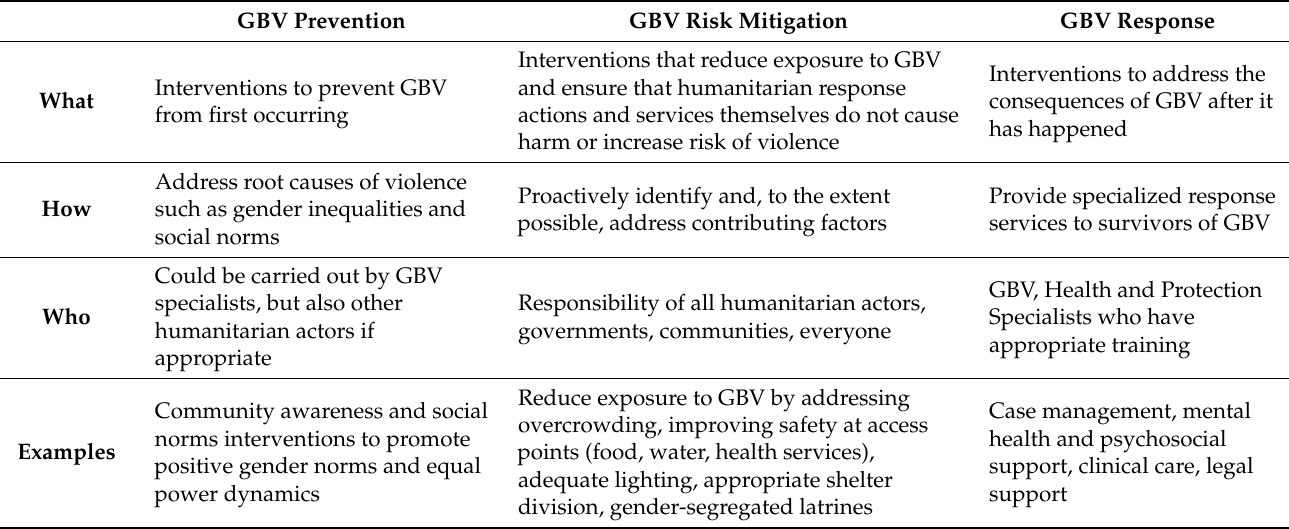
Table 1. The three pillars of GBV action in humanitarian emergencies. Adapted from the IASC GBV Guidelines training materials